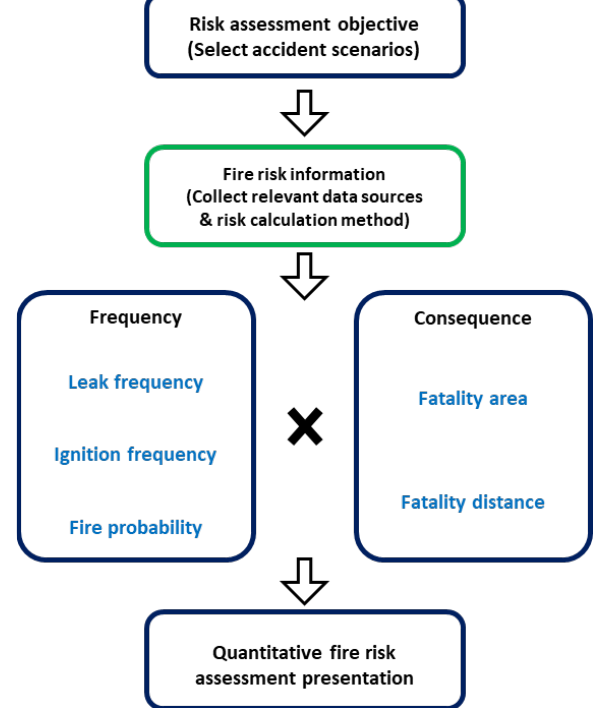
Figure 1. Quantitative fire risk assessment procedure.